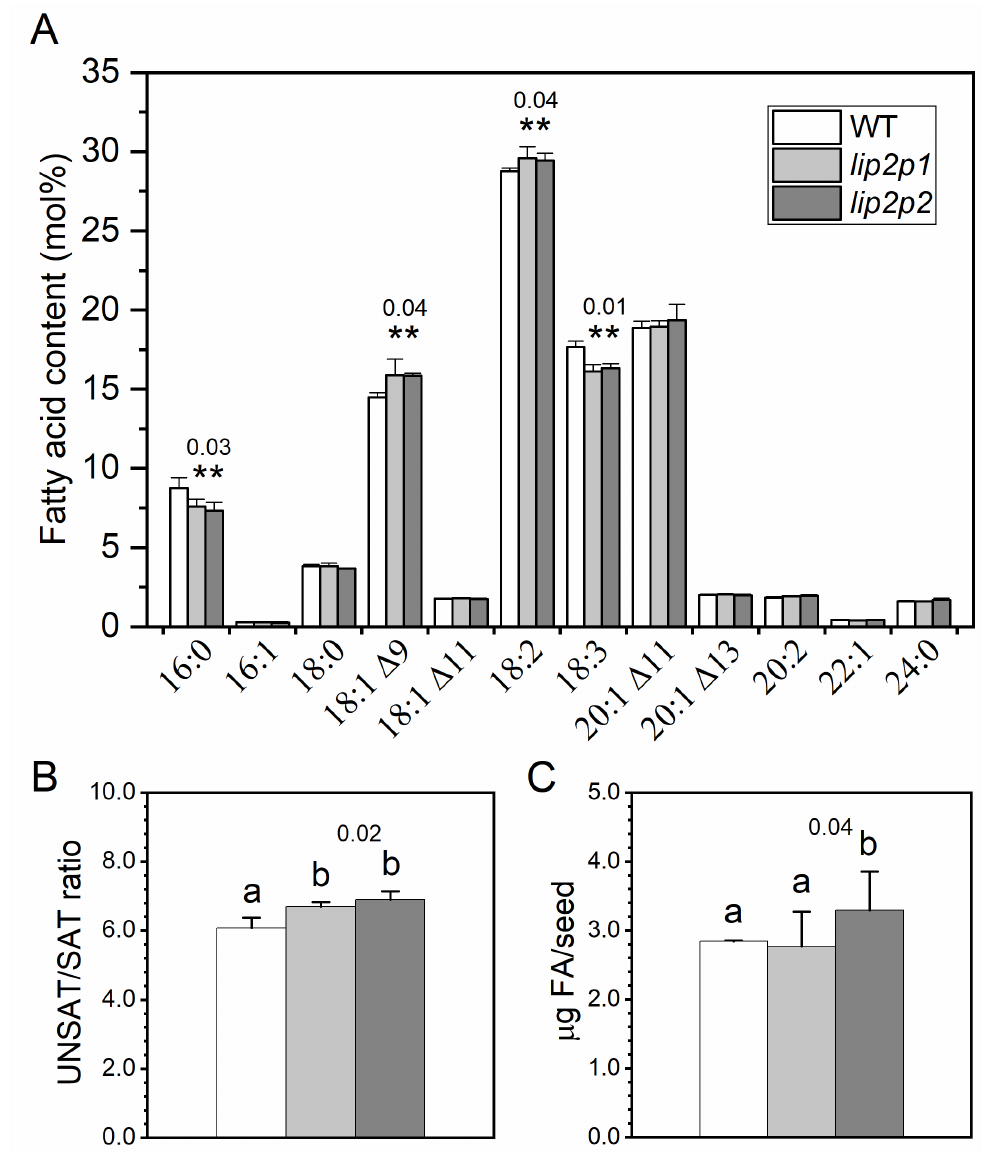
Figure 1. Fatty acids composition ( A ), unsaturated / saturated fatty acid ratio ( B ) and fatty acid content per seed ( C ) of mature seeds from control (wild type, WT) and octanoyltransferase mutants ( lip2p1 and lip2p2 ) lines. The data correspond to the mean ± SD of three independent measurements. ** At the 0.05 level, data are significantly di ff erent (showing p values). Di ff erent letters reflect the mean statistical di ff erence ( p < 0.05). 16:0, palmitic acid; 16:1, palmitoleic acid; 18:0, stearic acid; 18:1 ∆ 9 , oleic acid; 18:1 ∆ 11 , asclepic acid; 18:2, linoleic acid; 18:3, linolenic acid; 20:1 ∆ 11 , gondoic acid; 20:1 ∆ 13 ,